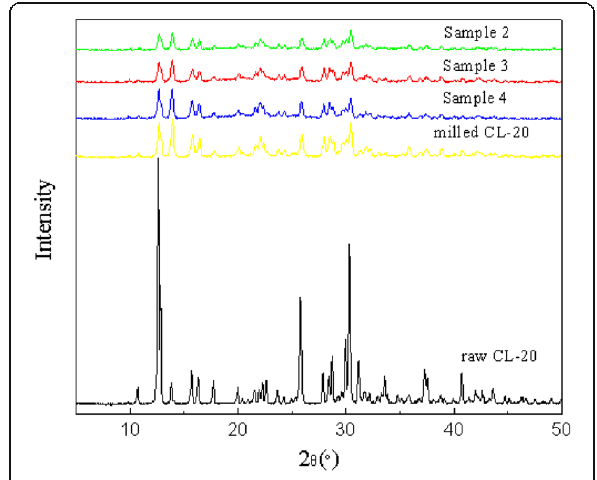
Fig. 3 X-ray diffraction patterns of samples